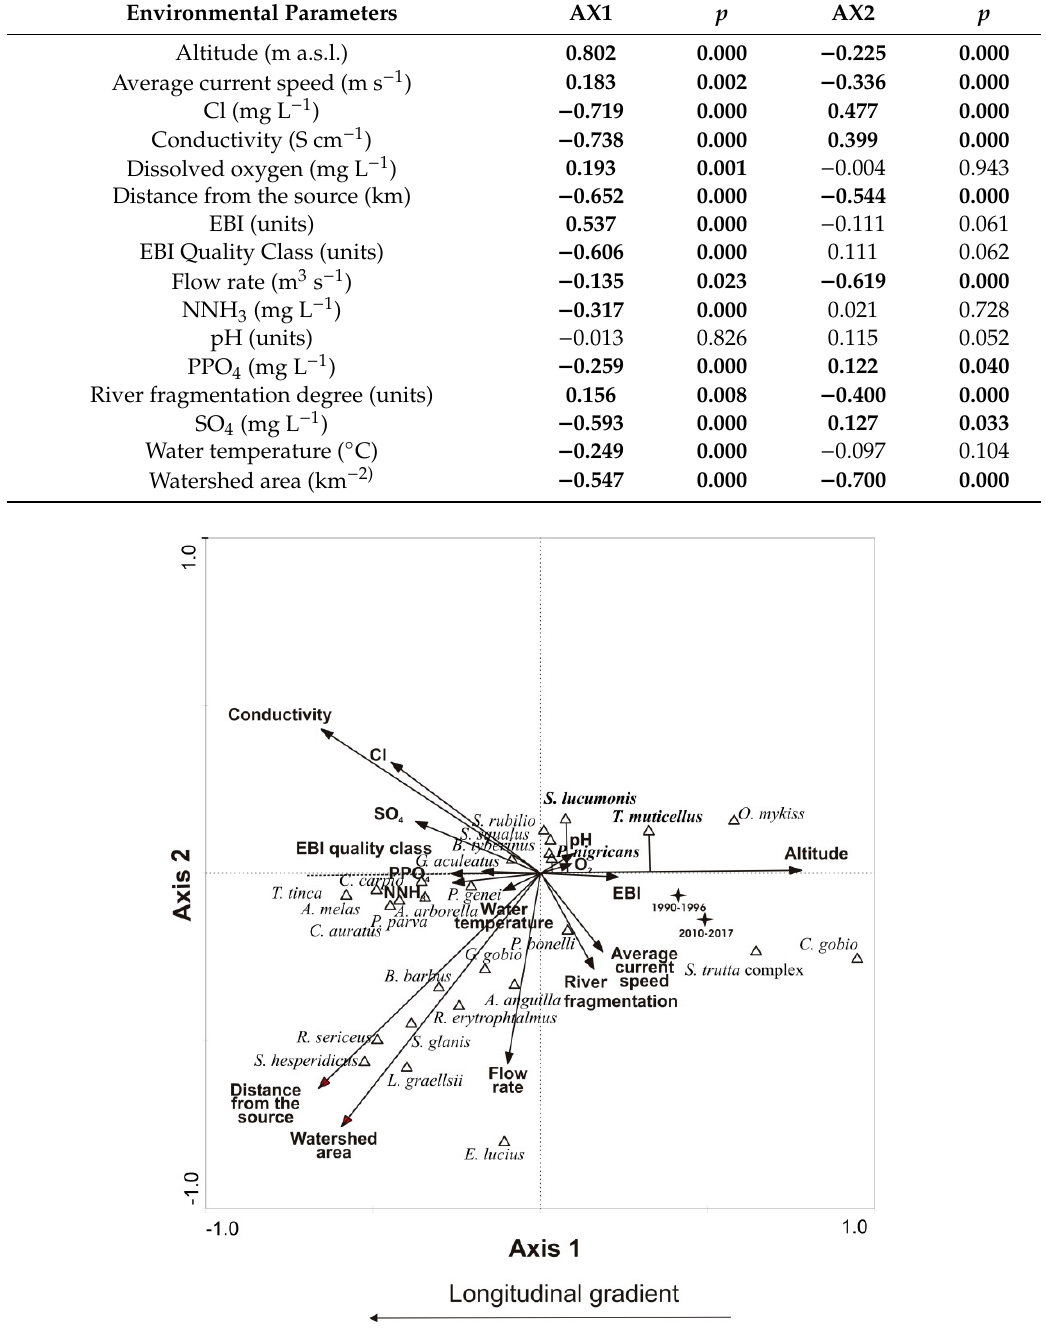
Figure 7. Canonical Correspondence Analysis results: biplot of fish and environmental variables for the census periods 1990–1997, 1998–2004, 2005–2011, 2012–2017. Black stars denote centroids of the periods 1990–1996 and 2010–2017, calculated as average scores of the samples belonging to those years. For S. lucumonis and T. muticellus the GLM results showed a progressive shift of the species towards river stretches located at higher altitudes, confirming their tendency to move upstream along the longitudinal gradient of the river (Figure 8a,b). For P. nigricans the GLM results showed a progressive increase of population abundances over time, whilst they did not result a significant variation in altitude preferences of the species (Figure